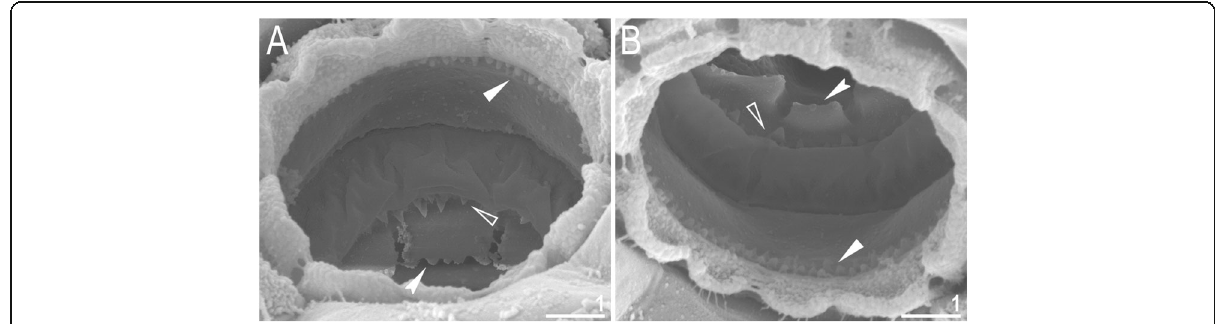
Fig. 8 Macrobiotus pallarii Maucci, 1954 from the topotypic population (IT.337) – the oral cavity armature seen with SEM: a – b – the oral cavity armature of a single specimen seen with SEM from different angles showing dorsal and ventral portion, respectively. Filled flat arrowheads indicate the first band of teeth, empty flat arrowheads indicate the second band of teeth, and filled indented arrowheads indicate the third band of teeth. Scale bars in μ